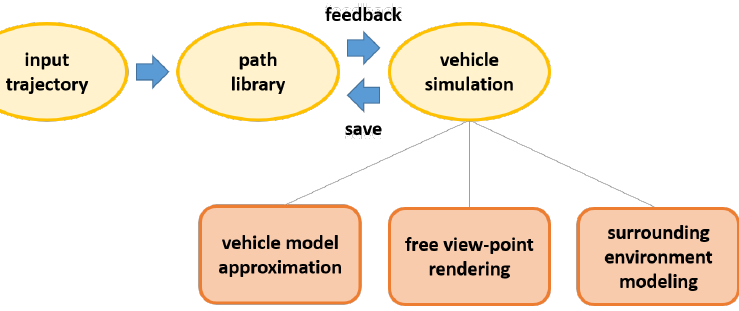
Figure 2. Overview of vehicle simulation on input trajectory.